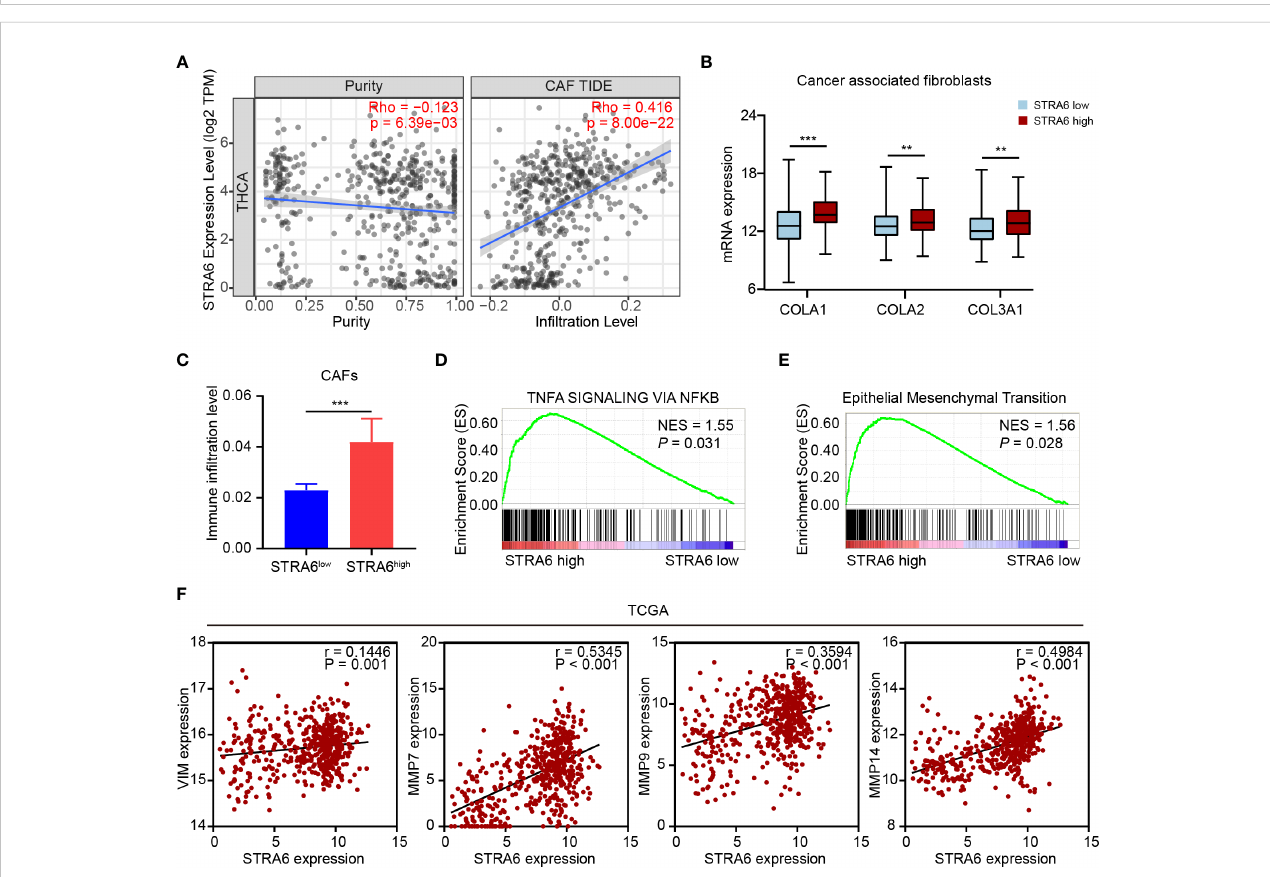
FIGURE 6 STRA6 promotes EMT process via increased CAFs in fi ltration. (A) The correlation of STRA6 expression with CAFs in fi ltration after purity adjustment. (B) mRNA expression of CAFs markers in PTC based on STRA6 expression. (C) In fi ltration level of CAFs in low-STRA6 PTC and high-STRA6 PTC. (D, E) GSEA results of TNF a /NF- k B signaling pathway and epithelial mesenchymal transition enrichment according to the TCGA database. (F) Scatter plot analysis of correlation between STRA6 mRNA expression and EMT markers. (**p < 0.01, ***p < 0.001. The data are shown as the mean ±